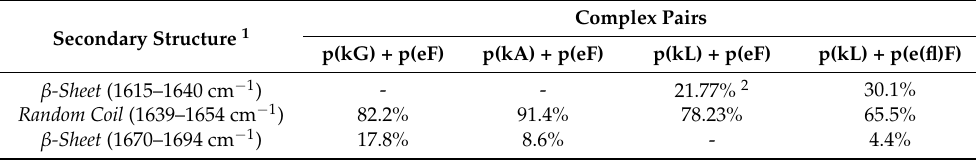
Table 3. Deconvolution analysis of FTIR spectra of sequences p(kG), p(kA), and p(kL) paired with p(eF), and p(kL) paired with p(e(fl)F). The curve fitting procedure is applied using Origin software. The area under the curves is measured with the Gauss function. Each secondary structure percentage is calculated by dividing the area of its assigned peak by the total area in the 1610–1700 cm − 1 range. Peaks center around 1610, 1625, 1645, and 1680 cm − 1 are considered in the secondary structure